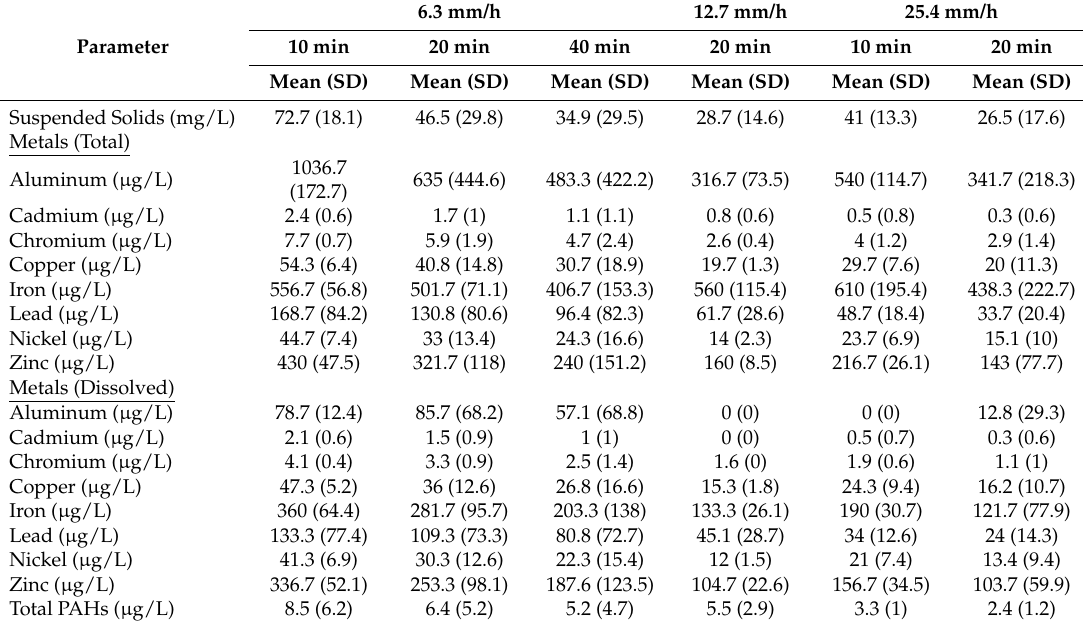
Table 2. Comparison of mean constituent concentrations ( ˘ standard deviation) during three different intensities and a range of durations. N = 3 for each time